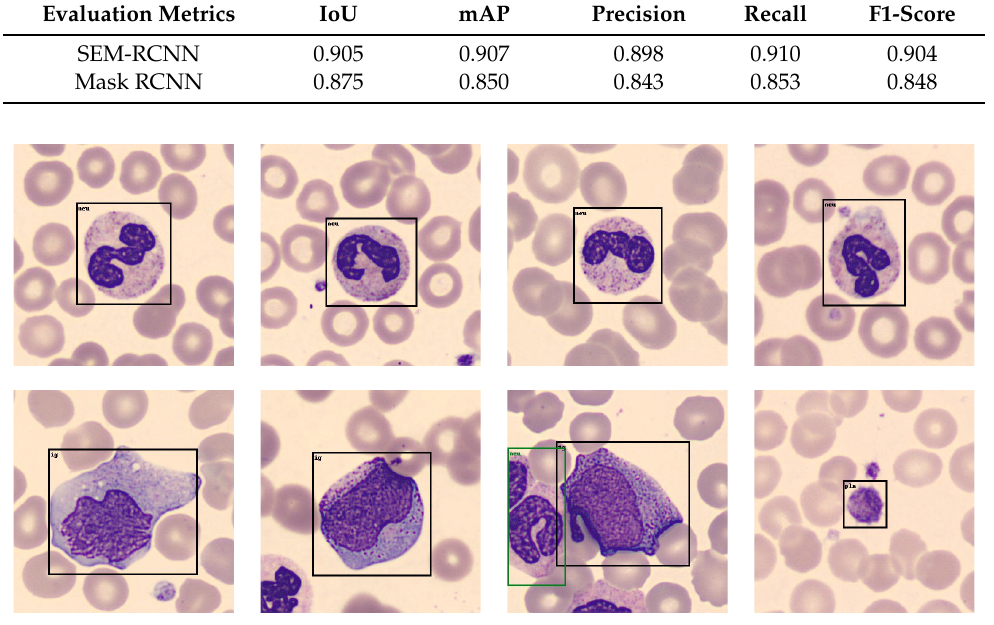
Figure 17. The results of SEM-RCNN for cell dataset detection.The color boxes indicate the positions predicted by SEM-RCNN, for which its captions indicate the predicted